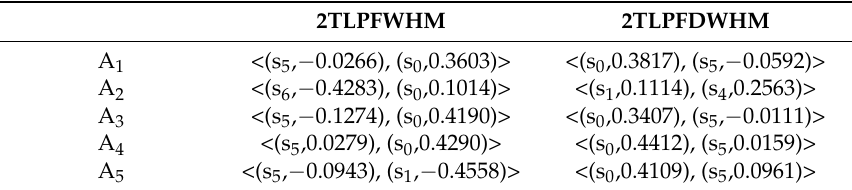
Table 5. The fused results of the green suppliers by 2TLPFWHM (2TLPFDWHM) operator.